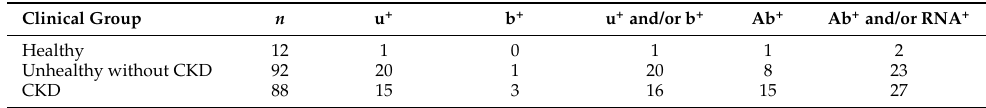
Table 6. Number of cats in each clinical group ( n ) positive to FeMV according to the positivity by qPCR FeMV from urine (u + ), blood (b + ), urine and/or blood (u + and/or b + ), FeMV antibodies (Ab + ), FeMV Abs and/or qPCR FeMV (Ab + and/or RNA + ). CKD = chronic kidney disease.